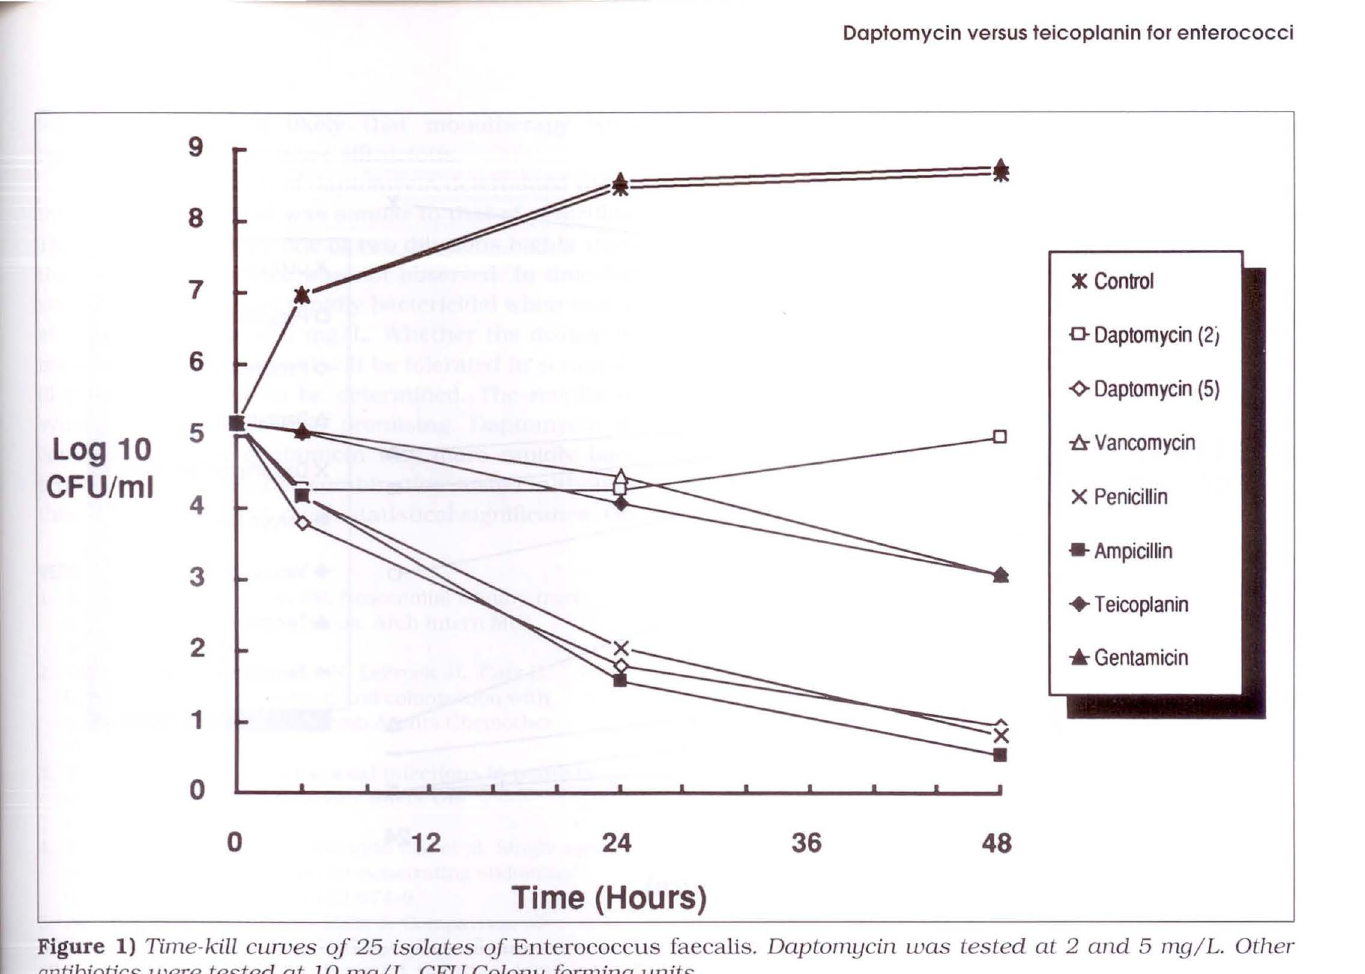
Figure 1) Time-kill curves of 25 isolates of Enterococcus faecalis. Daptomycin was tested at 2 and 5 mg/L. Other antibiotics were tested at 10 mg/ L. CFU Colony forming